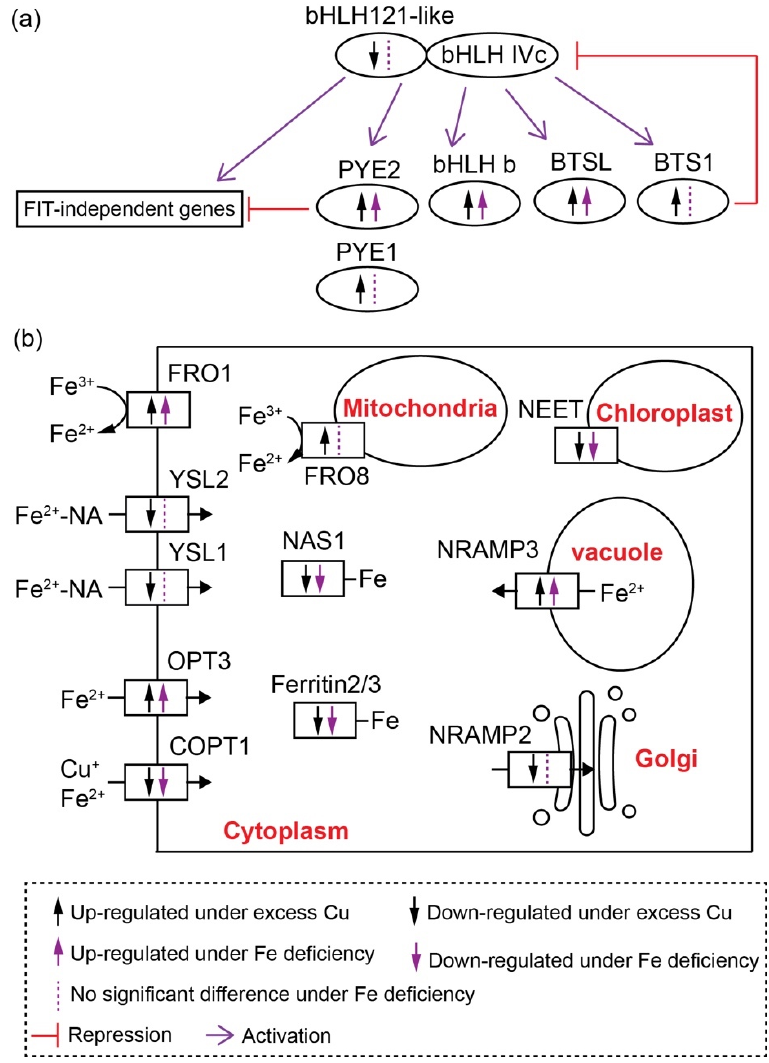
Figure 5. Schematic diagram of genes involved in Cu–Fe crosstalk in petunia petal: ( a ) expression profile of transcription factors involved in Fe homeostasis, ( b ) expression pattern of genes involved in Fe transport and distribution in petunia petals. bHLH, basic-helix-loop-helix; PYE, popeye; BTS, Brutus; BTSL, Brutus-like; NRAMP, Natural resistance-associated macrophage proteins; NAS, Nicotianamine synthases; FRO, ferric reductase oxidase; YSL, Yellow stripe-like proteins; OPT3, Oligopeptide transporter3; COPT1, copper transporter1.